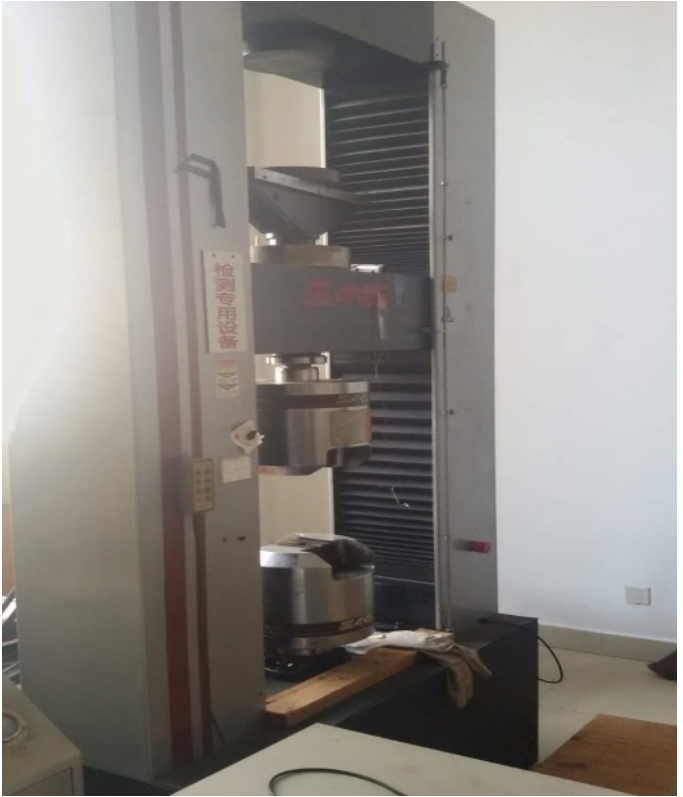
Figure 5. The 600 kN microcomputer controlled electro-hydraulic servo universal testing machine.